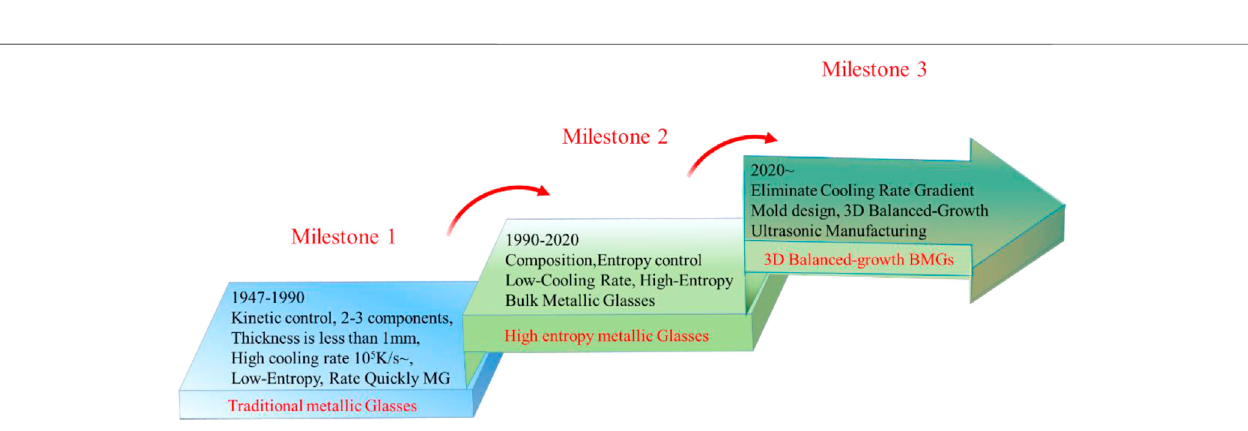
FIGURE 12 | Development stages in amorphous alloy